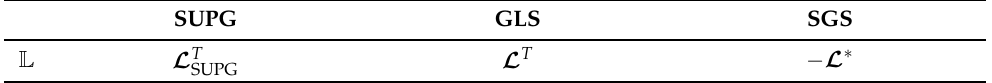
Table 1. Relationship between differential operator and type of stabilized